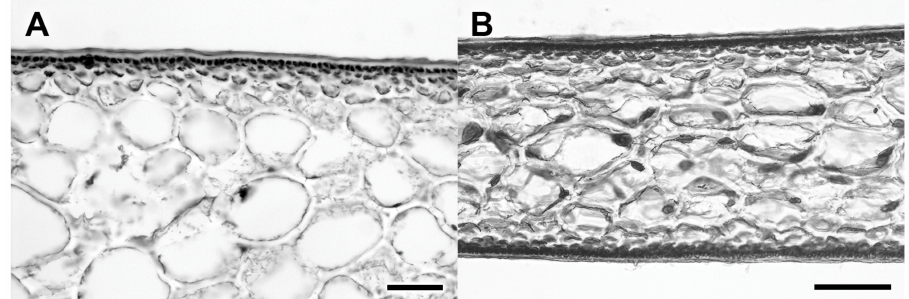
Figure 3. Gracilaria parva sp. nov., internal vegetative anatomy. ( A ) Transverse section, PHYKOS- 4541, specimen WNC-34186. Scale = 50 µ m. ( B ) Longitudinal section, PHYKOS-4541, specimen WNC-34186. Scale = 100 µ m.